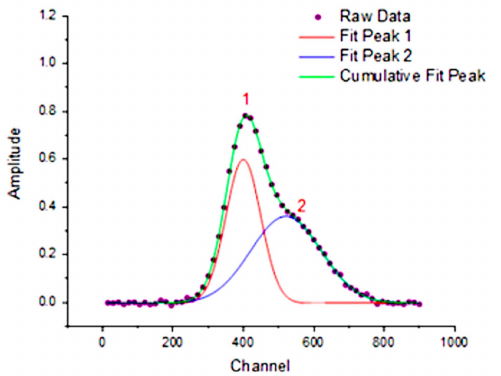
Figure 2. Example of XRD peak deconvolution.